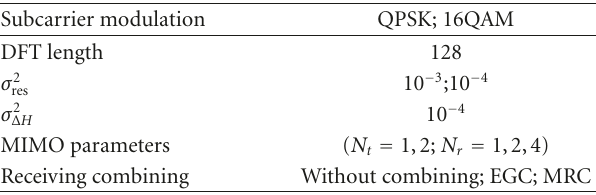
Table 1: Parameters for BER simulation in MIMO-OFDM